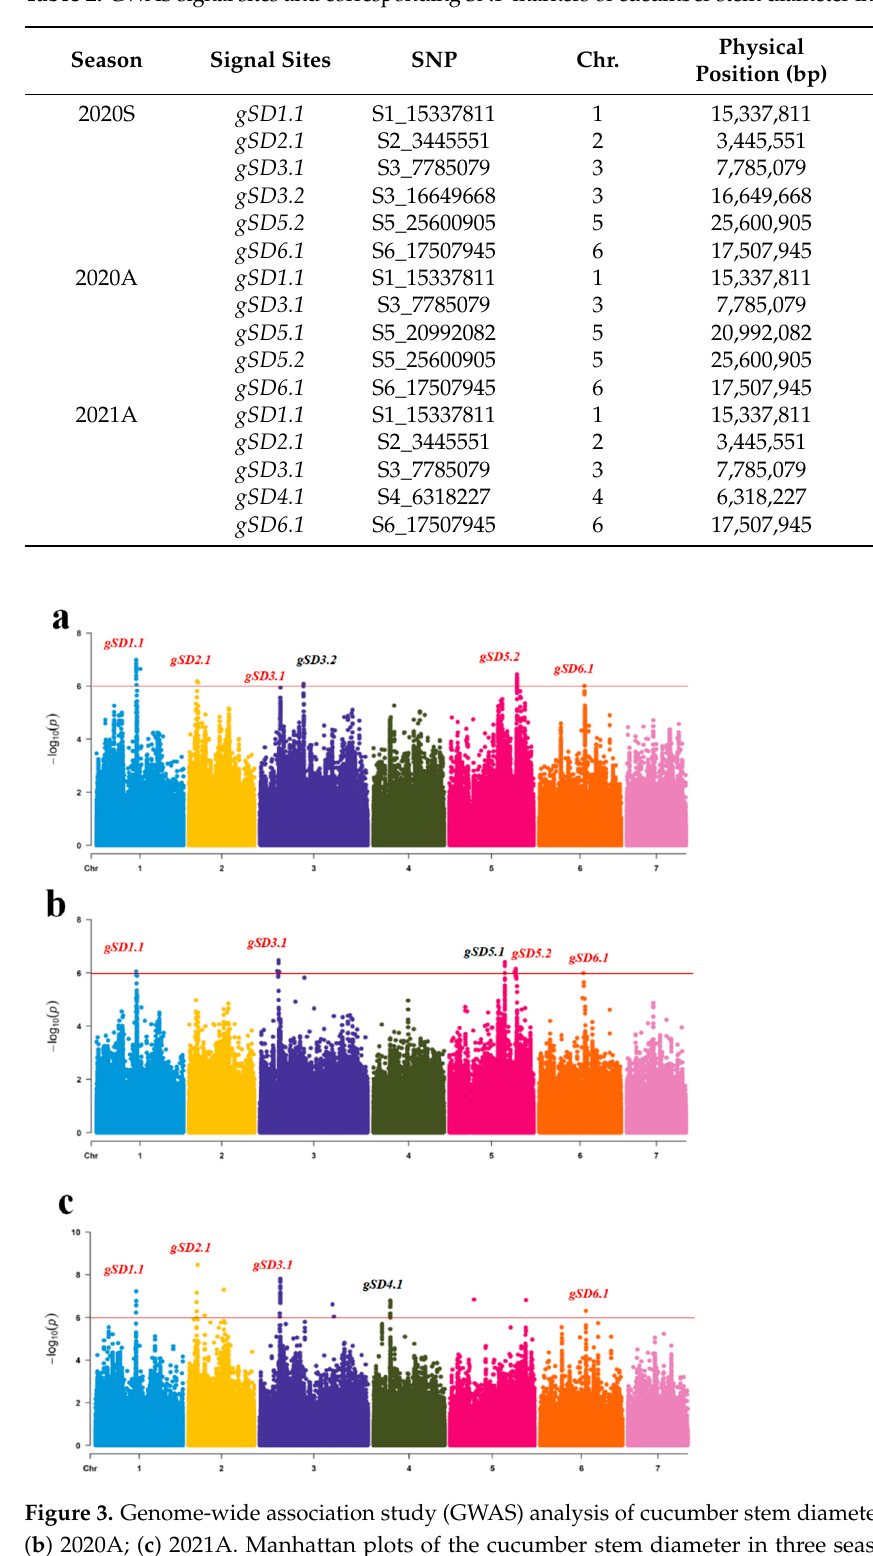
Table 2. GWAS signal sites and corresponding SNP markers of cucumber stem diameter in three seasons.